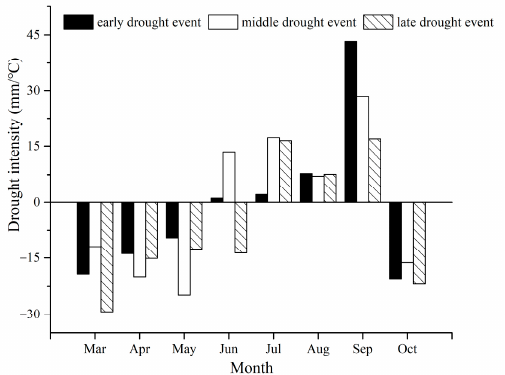
Figure 10. The differences between the average values of the de Martonne aridity index at SDL3 and SDL4 (the different sampling sites are shown in Table 1.) in the drought years and the value of 30. The time period of the early drought is 1971, middle drought is 1995, late drought is 2001.